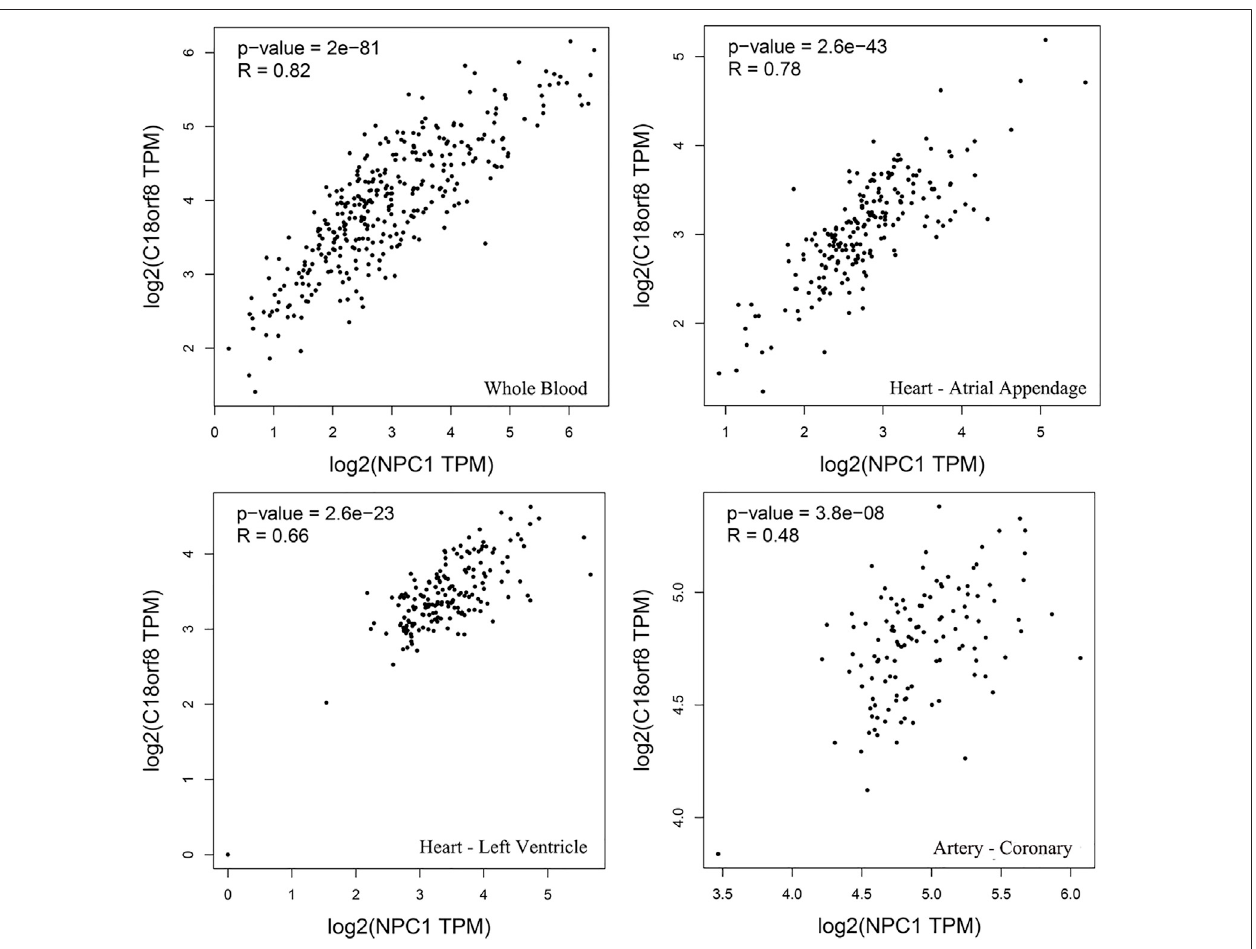
FIGURE 5 | Gene expression pro fi ling interactive analysis. The expression of the two genes indicates a signi fi cant correlation in human whole blood, atrial appendage, left ventricle and coronary tissues.